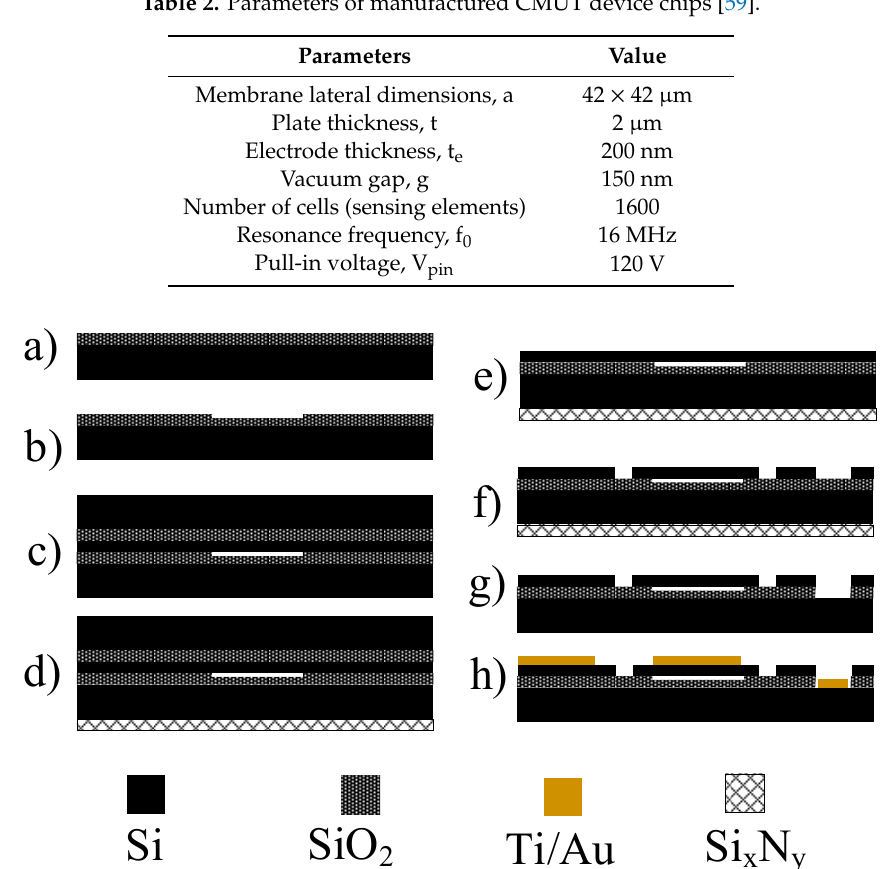
Figure 2. CMUT wafer bonding fabrication steps: ( a ) Thermal oxidation; ( b ) oxide wet etching; ( c ) wafer bonding; ( d ) backside protection with plasma enhanced chemical vapor deposition (PECVD) silicon nitride; ( e ) handle wafer removal using CMP and wet etch; ( f ) Oxford cryogenic etching process for separating devices by etching device layer; ( g ) opening of contact pads with reactive ion etch (RIE), ( h ) top electrode formation and contact pads metallization using lift-off procedure.